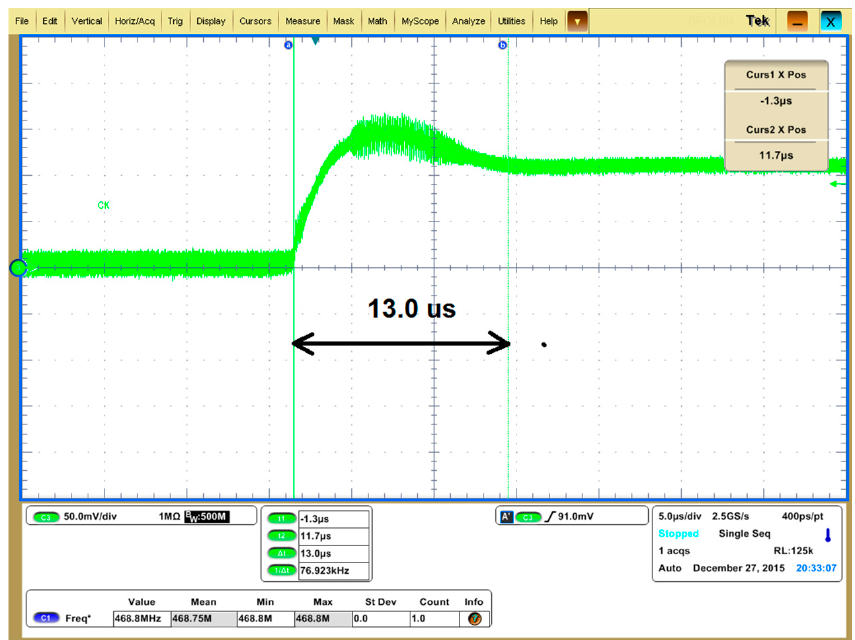
Figure 21. Measured PLL settling time. The curve shows the settling process of the VCO control voltage V C when the PLL frequency setting is changed.